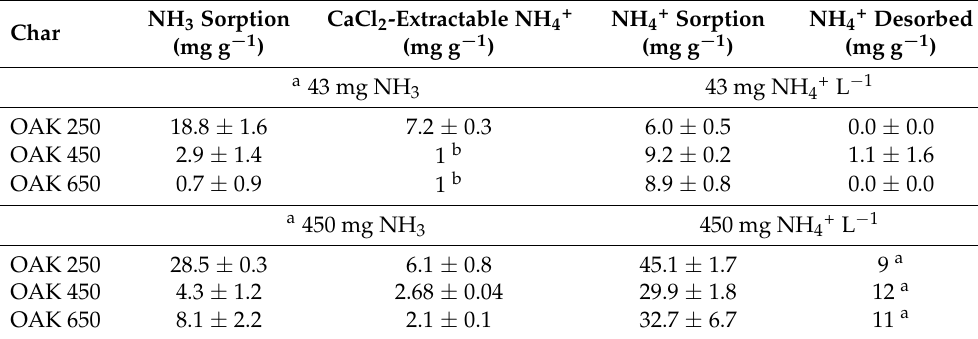
Table 1. Char sorption and release profiles for gaseous NH 3 and aqueous NH 4+ .